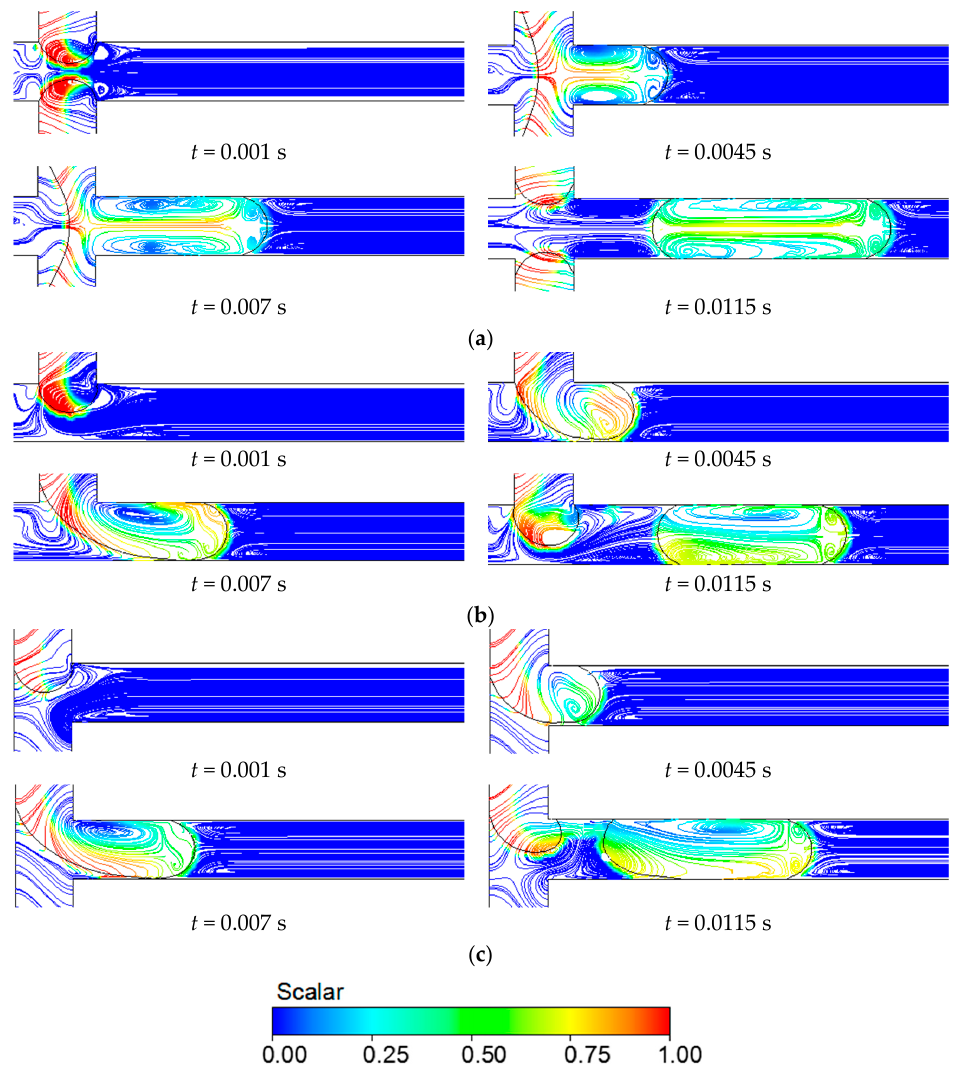
Figure 8. Scalar distribution in the droplet forming stage. u total = 50 mm/s, ε d = 0.5. ( a ) Cross-shaped junction; ( b ) Cross-shaped T-junction; ( c ) T-junction.